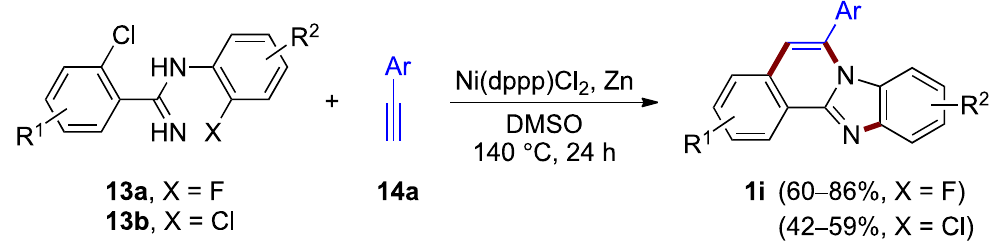
Figure 12. Nickel-catalyzed annulation of chlorohalobenzimidamides 13 with terminal alkynes 14a . A copper(II) acetate-catalyzed cascade cyclization reaction between o -alkynylbenzo-